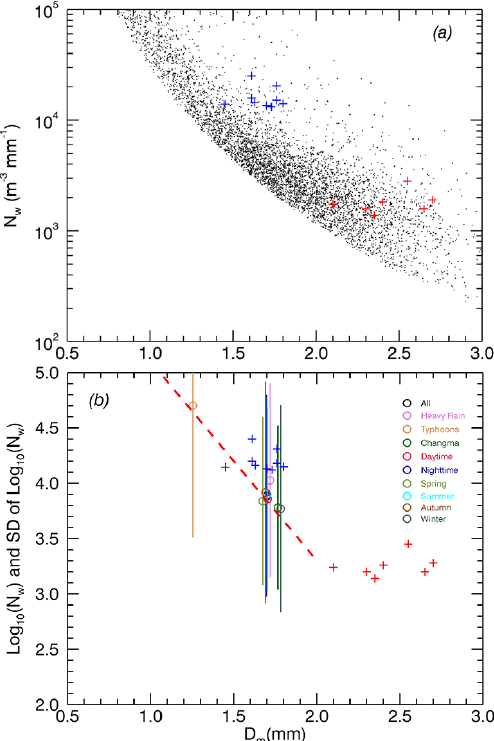
Figure 6. (a) As in Fig. 5a but for convective rainfall. The blue and red plus symbols represent maritime and continental rainfall, respectively, as defined by Bringi et al. (2003). (b) As in Fig. 5b but for convective rainfall. The broken red line represents the mathe- matical expression described in Eq.